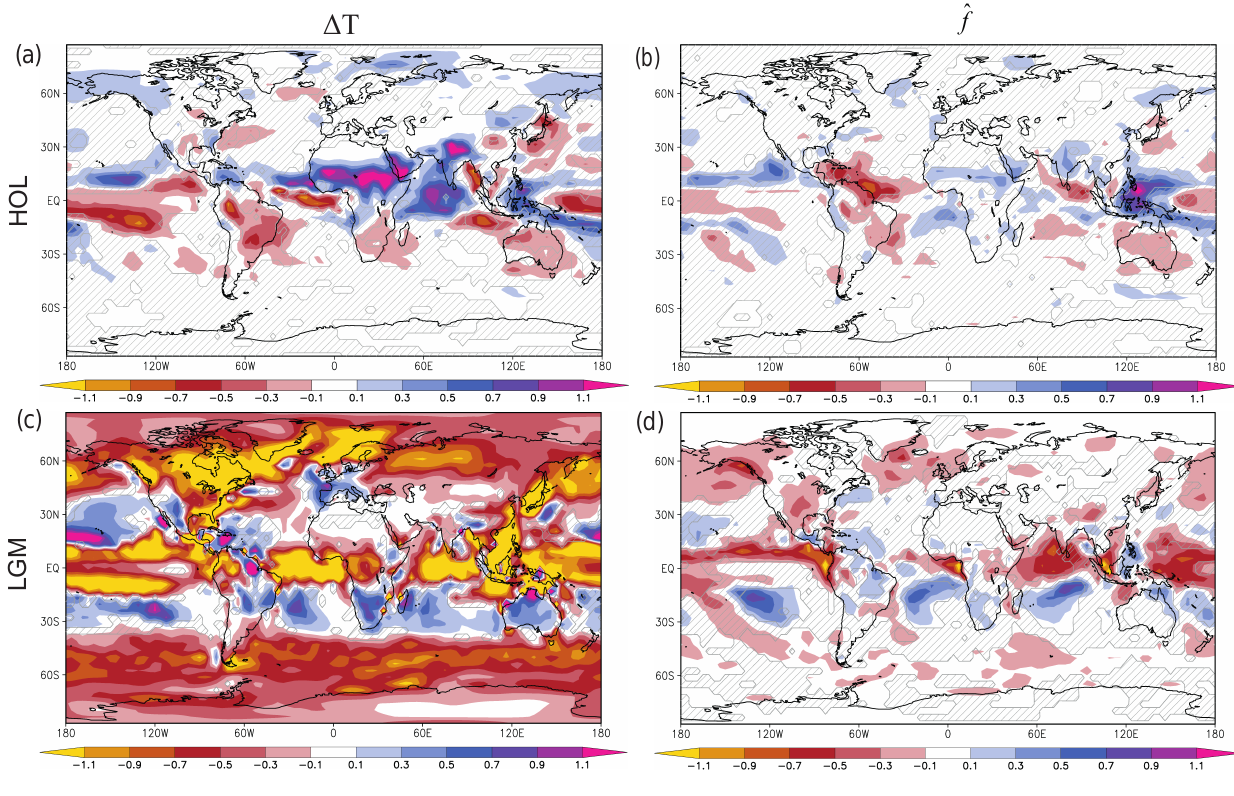
Figure 5. As Fig. 4 but for total precipitation (mmday − 1 ).